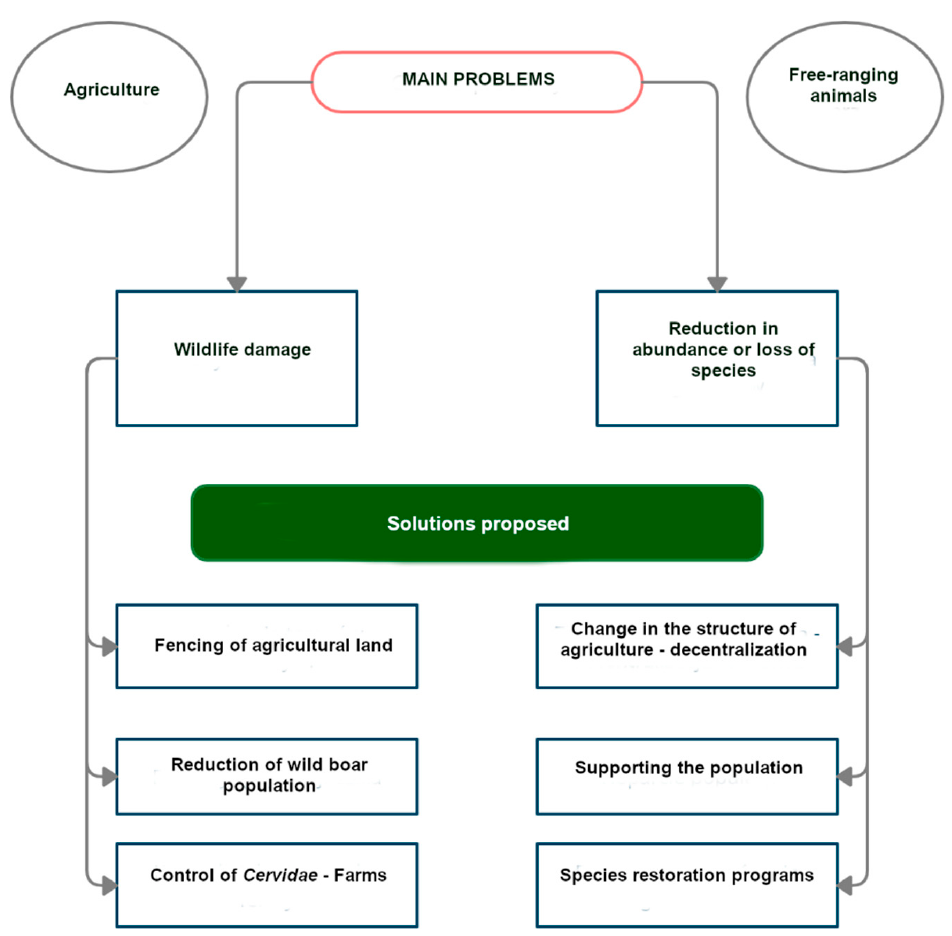
Figure 2. Basic interaction problems and examples of their solutions.